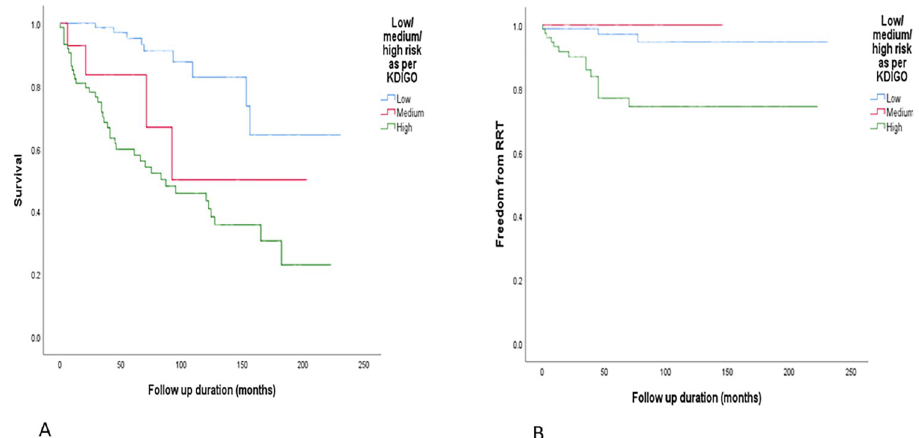
Fig 4. Overall survival (A) and freedom from RRT (B) in patients categorised as low, medium, and high-risk of progression. P values < 0.001 and 0.001 respectively (Chi-squared).